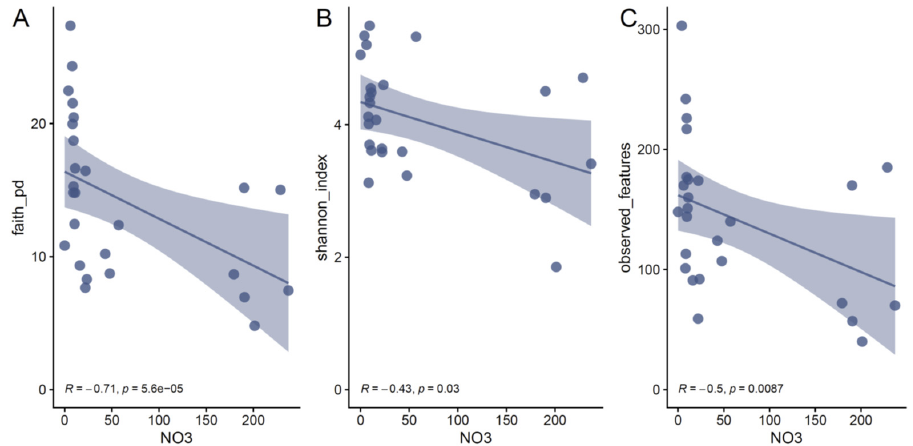
Figure 3. Nitrate concentration is correlated with bacterial alpha diversity in oil reservoirs at a localized geographic scale. ( A ) the correlation between the Faith’s PD index and the nitrate